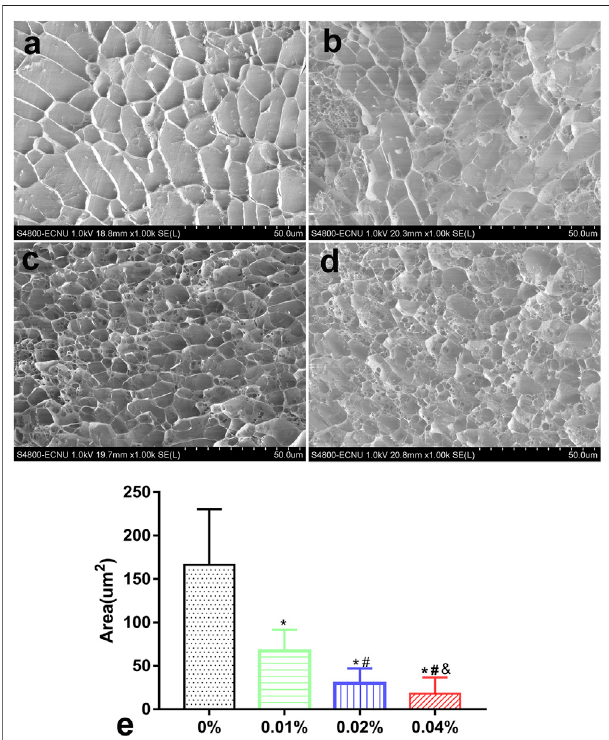
FIGURE 2 | The GHD microstructure observation and grid area measurement by a cryoelectron microscope. Cryoelectron microscope images of GHD in the (A) 0%, (B) 0.01%, (C) 0.02%, and (D) 0.04% groups. (E) The quanti fi cation of the average grid area of GHD cross-linked